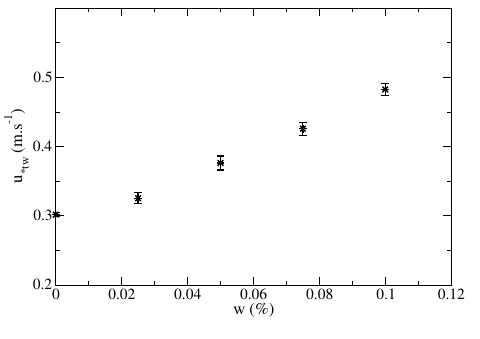
Figure 4. Aerodynamic threshold friction speed as a function of the water content